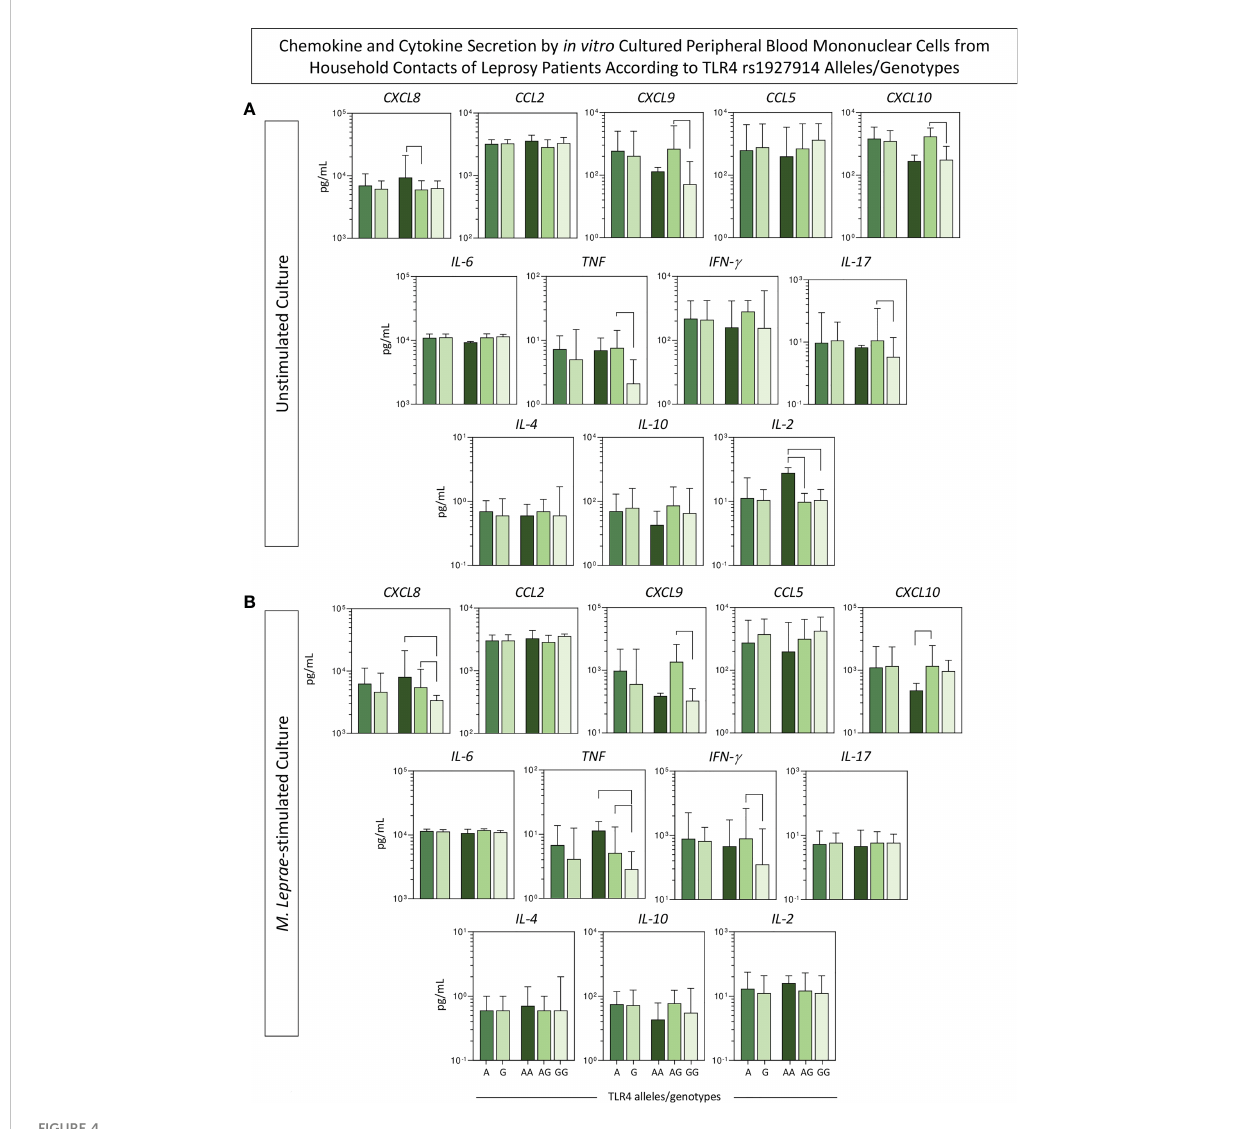
FIGURE 4 Chemokine and cytokine secretion by in vitro cultured peripheral blood mononuclear cells from household contacts of leprosy patients according to TLR4 rs1927914 alleles/genotypes. The levels of chemokines (CXCL8, CCL2, CXCL9, CCL5, CXCL10) and cytokines (IL-6, TNF, IFN- g , IL-17, IL-4, IL-10 and IL-2) were measured in the supernatant collected upon in vitro culture of PBMC from household contacts of leprosy patients categorized according to the TLR4 rs1927914 alleles/genotypes as follows: A